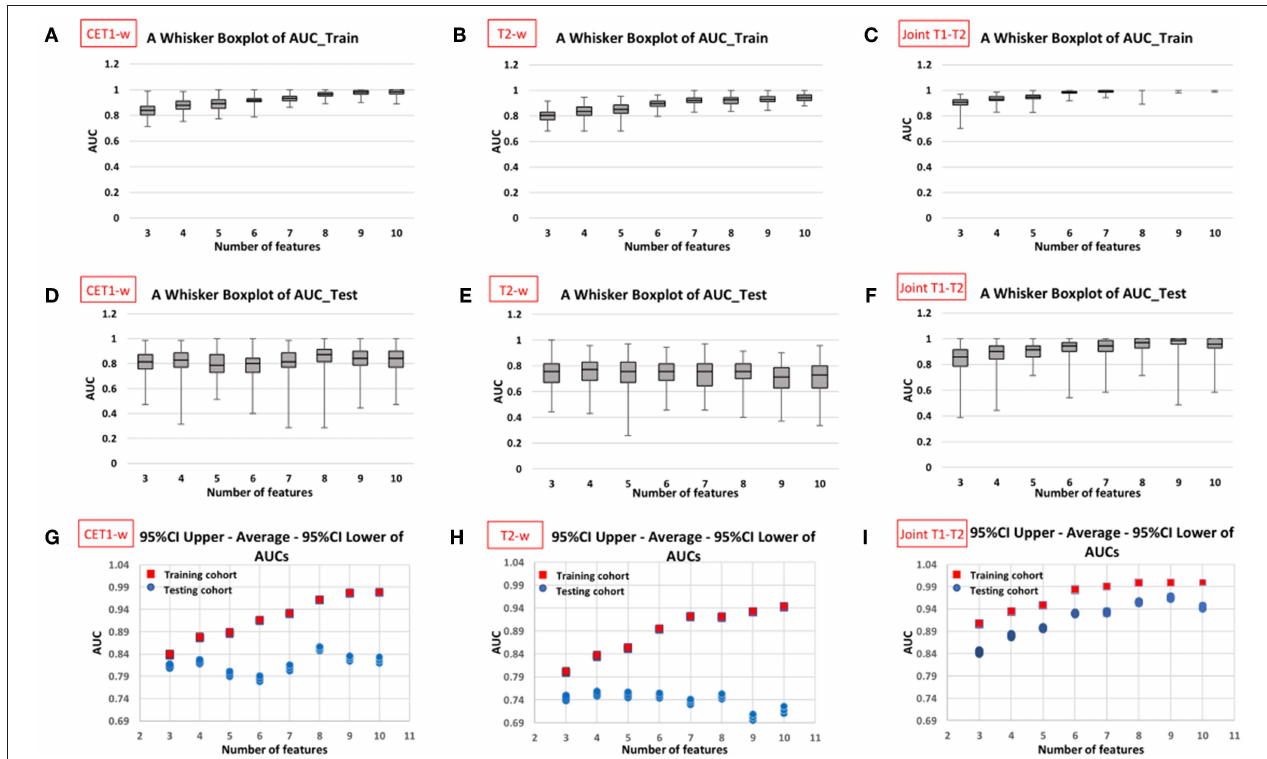
FIGURE 5 | Distribution of AUC values in training and testing cohorts against different number of features in the constructed models from 100 resampled iterations of 20-repeated 3-fold cross validation (CET1-w model: first column, T2-w model: second column, and Joint T1-T2 model: third column). The box and whisker plots in first (A–C) and second rows (D–F) display the AUC distributions with varying number of selected features in training cohort and testing cohort, respectively; the plots in third row (G–I) displays 95% confidence interval and average AUCs for both cohorts against number of selected features in the models.